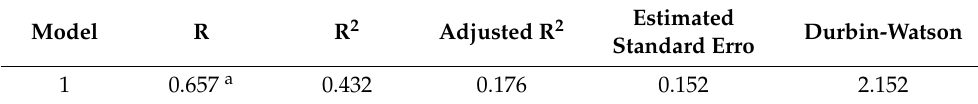
Table 5. Summary of multiple linear regression models of the SDI and proportion of landscape elements.